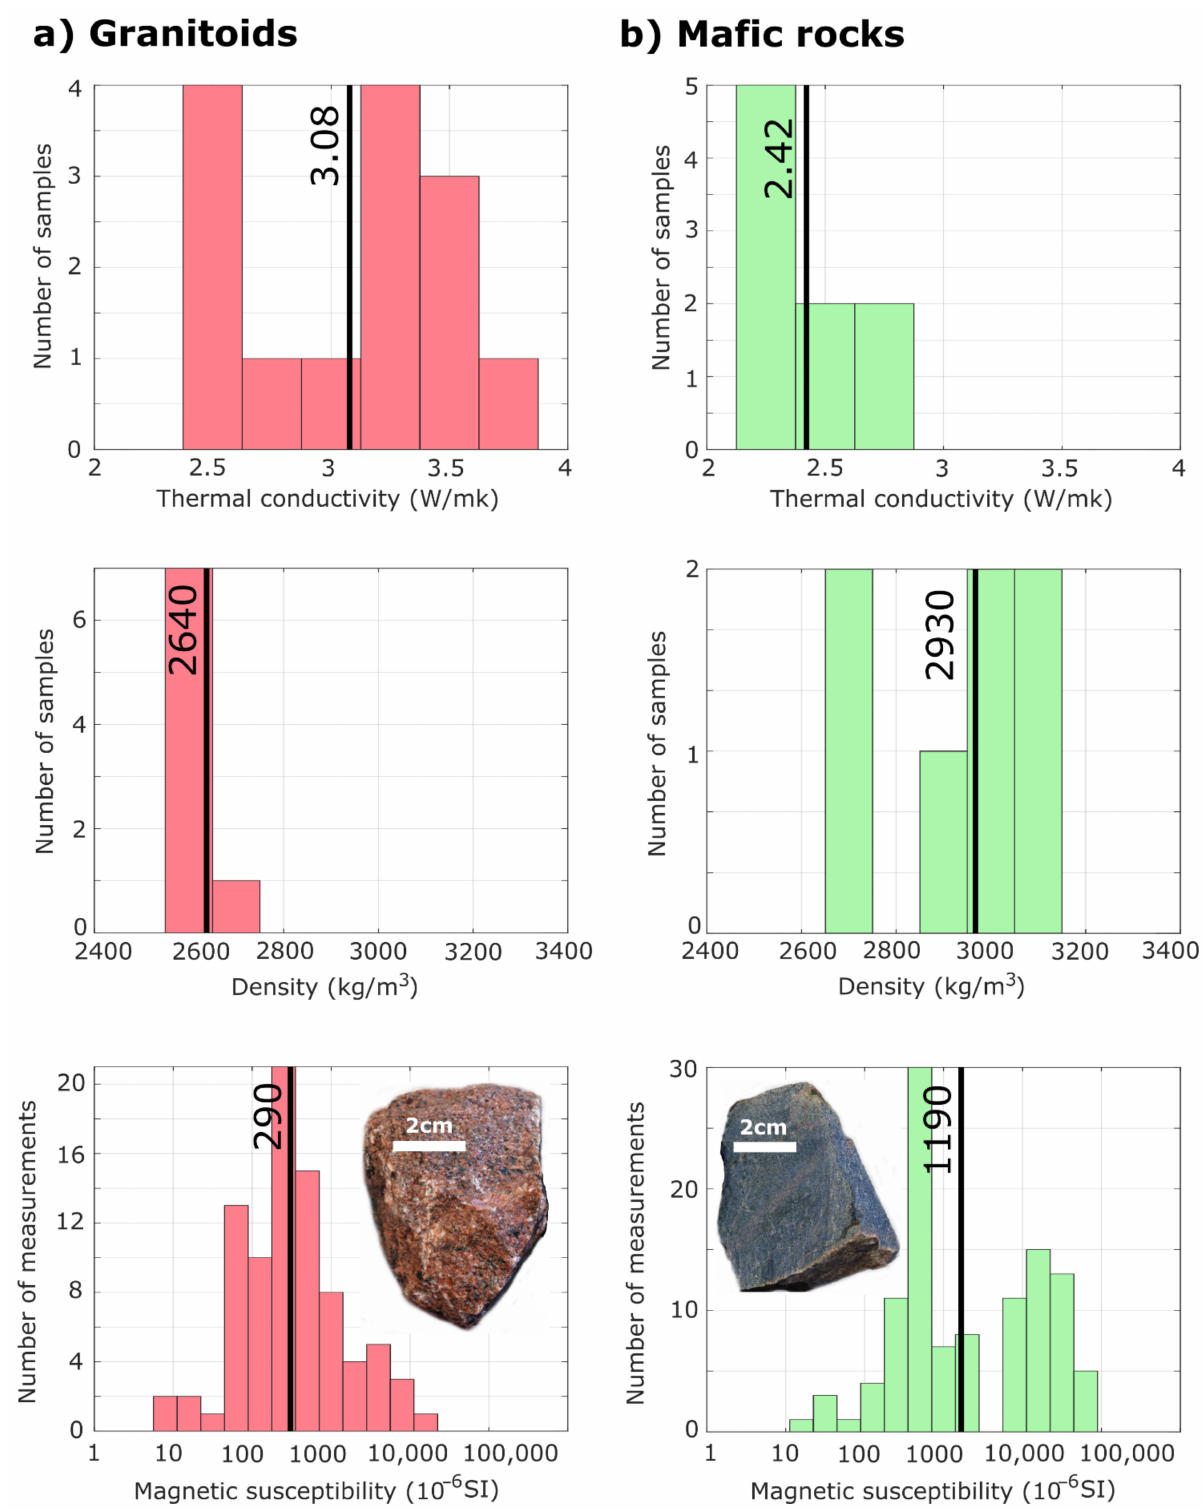
Figure 4. Petrophysical data for granite and mafic rock types. Histograms showing thermal conductivity data ( top ), density data ( center ), and magnetic susceptibility data ( bottom ), are shown for each rock type. The thick black lines display the average values for each plot. The mean average value is shown for the thermal conductivity and density data, while the median average is shown for the magnetic susceptibility data. A close-up image of each rock type is shown on the magnetic susceptibility graph. ( a ) Graphs on the left are for Granitoids. ( b ) Graphs on the right are for Mafic